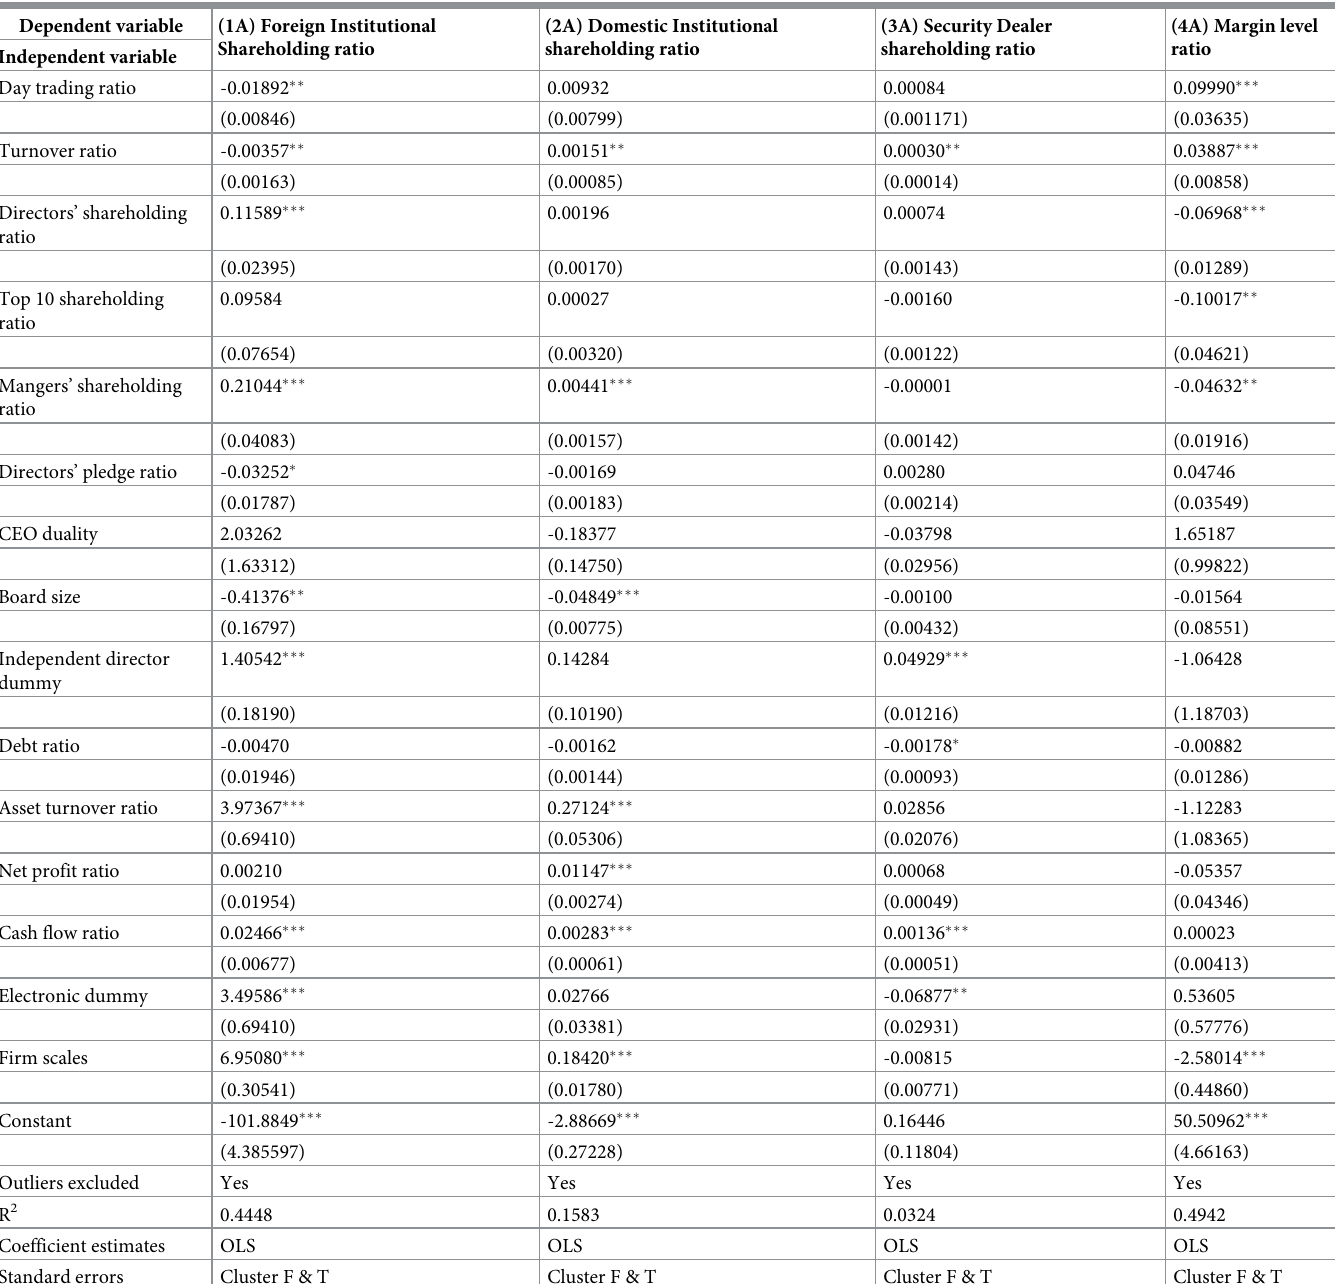
Table 3. Results of shareholding behaviors for diverse